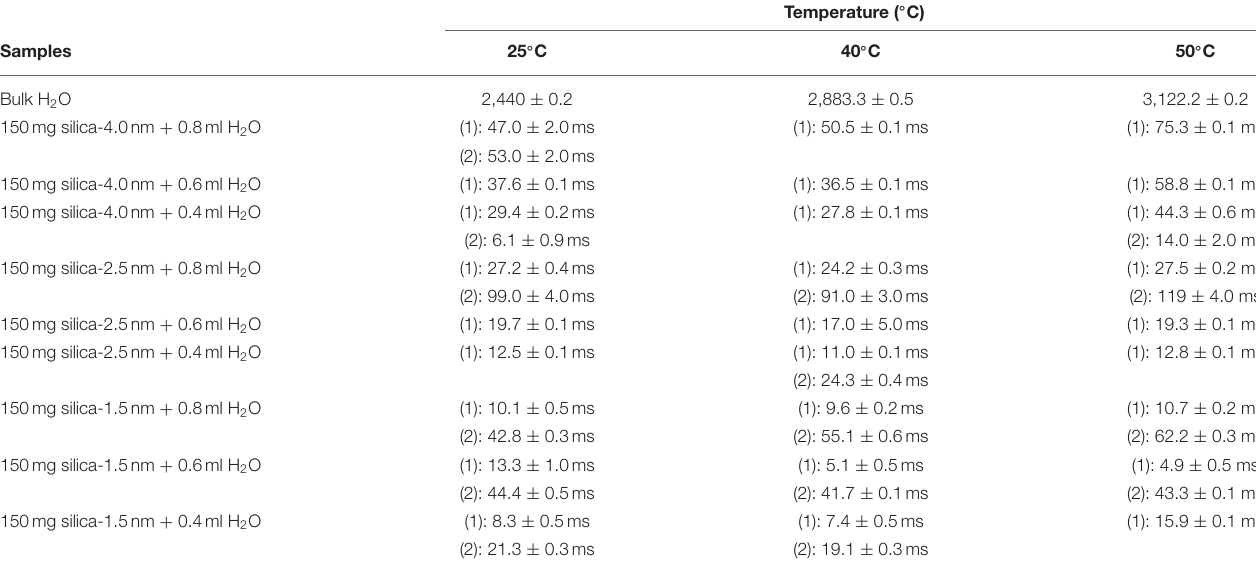
TABLE 4B | Transverse magnetization relaxation times (T 2 ) of confined water obtained after sonication of the mixtures for 15 min.